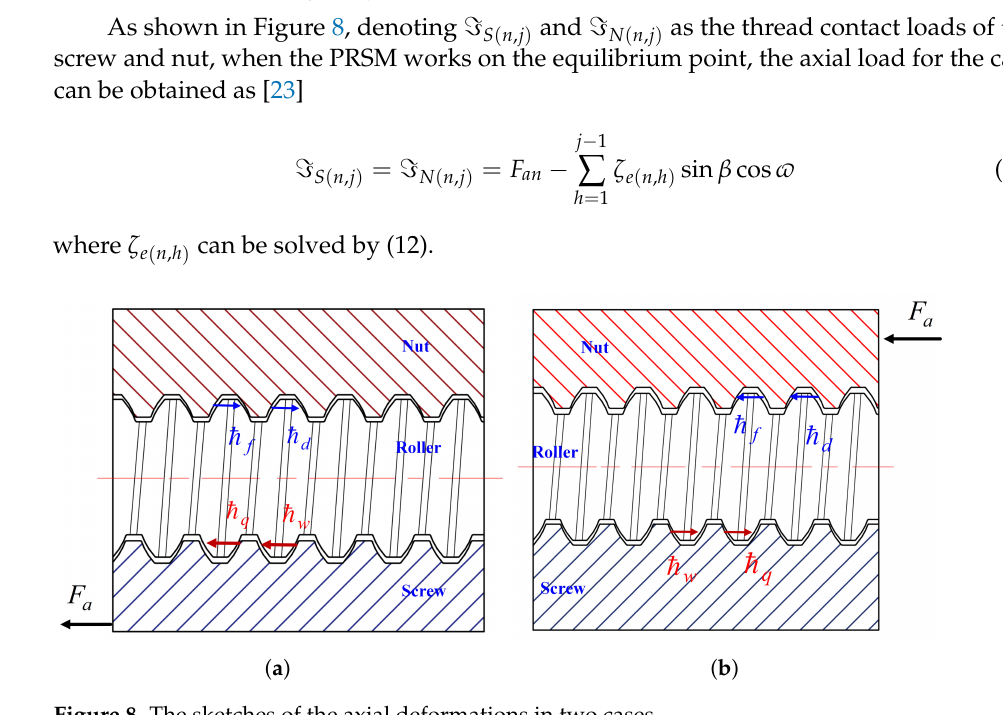
Figure 8. The sketches of the axial deformations in two